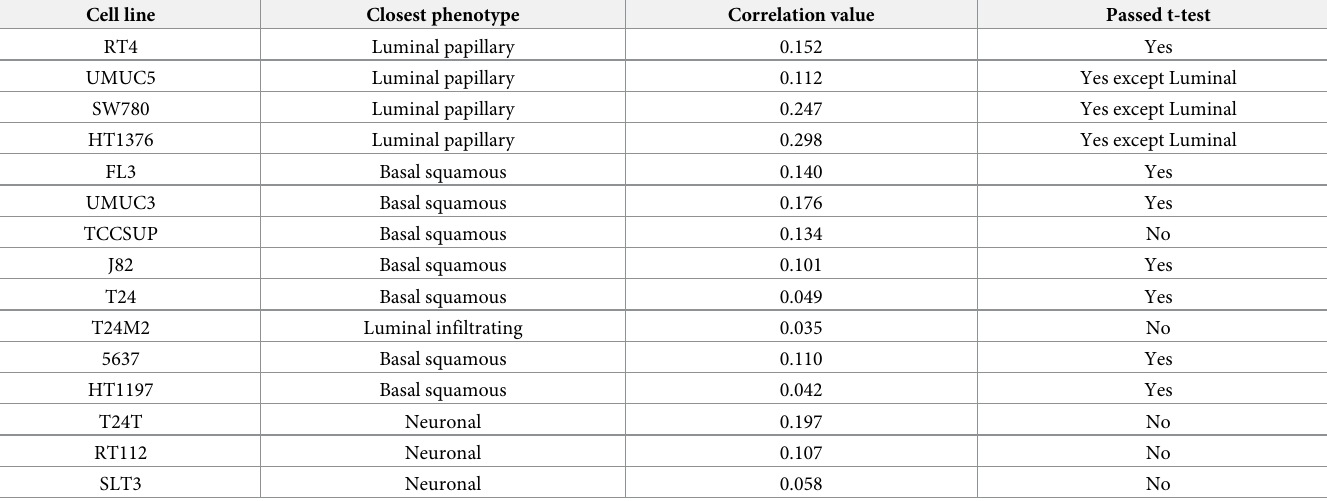
Expression profiles for 31 TKs among TCGA patient samples were significantly correlated with molecular phenotype (neuronal, basal squamous, luminal, luminal infiltrating, and luminal papillary) and OS (p = 1.00 x10-4, q = 8.97 x 10–5, F 2,405 > 9.42, R 2 > 0.044 for the 3-group comparison F test: LP vs. (LI + L) vs. (BS +N). Cell line expression profiles for the TKs were compared with the respective TCGA patient tumor TK profiles and assigned to a molecular phenotype if its mean correlation coefficient was distinguished from the respective coefficients for the other phenotypes by t-test at p <